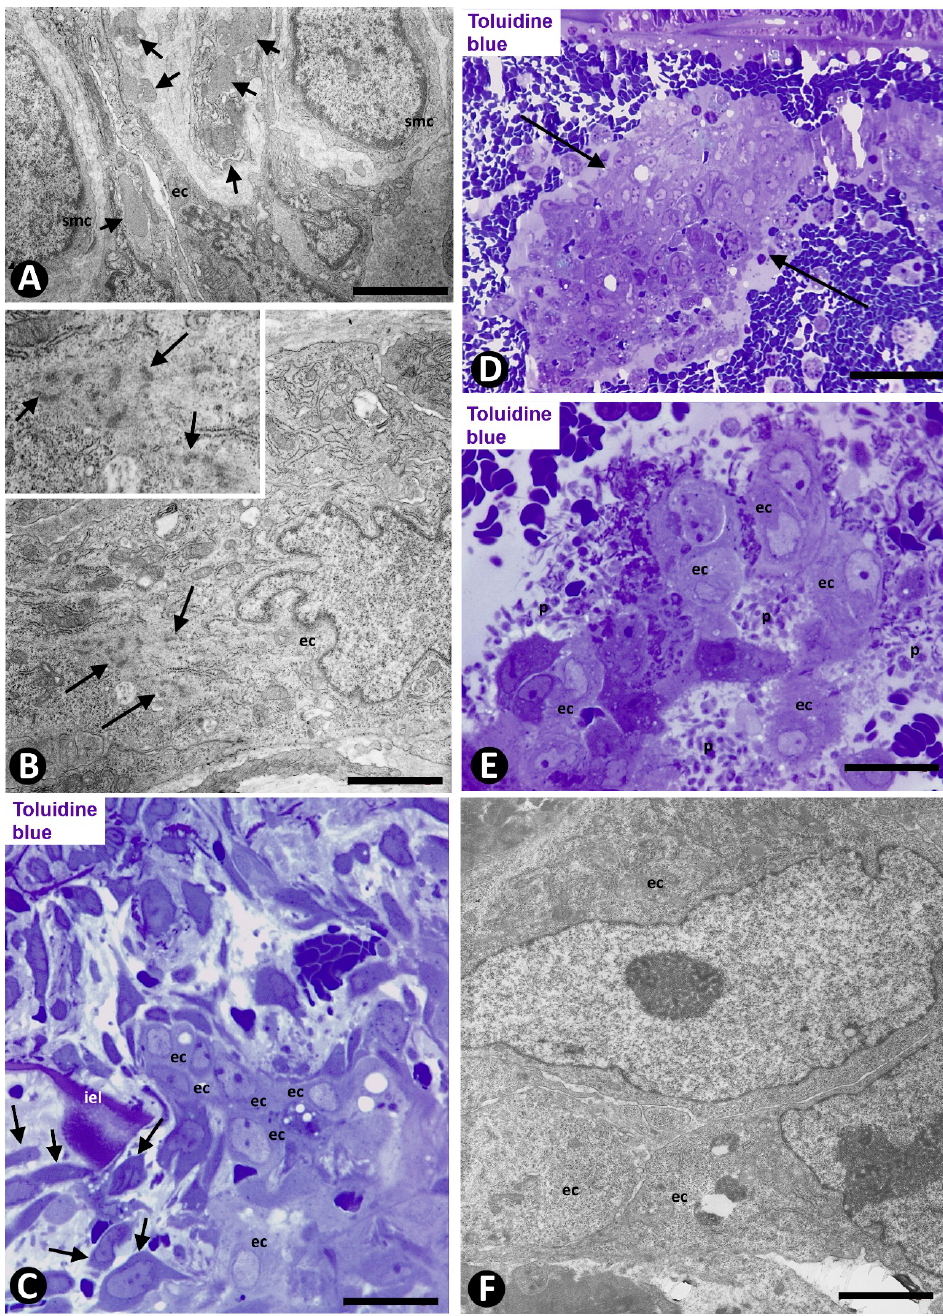
Figure 6. Angiogenesis in experimental occluded arterial segments. ( A , B ). Smooth muscle cells (SMCs) (smc) and ECs (ec) in capillaries with prominent nuclei and cytoplasms with abundant ribosomes. Numerous globular structures are seen in the interstitium and invaginated into Ecs (A, arrows). Stress fibers (arrows) are observed in ECs (B and insert). ( C ) One capillary is seen penetrating the arterial internal elastic lamina (iel). Note that VSMs (arrows) extend over the luminal surface of this lamina and that ECs (ec) form an aggregate. ( D – F ) Aggregates of ECs (arrows in D), between red blood cells and numerous platelets (p in E), in the arterial lumen. ECs (ec) are voluminous with large nuclei and prominent nucleoli ( D – F ). ( A , B , F ) Ultrathin sections. Uranyl acetate and lead citrate. ( C – E ) Semithin sections: Toluidine blue. Bar: ( C , E ): 10 μ m; ( D ): 40 μ m; ( A ): 4 μ m; ( F ): 2 μ m; ( B ): 1 μ m.